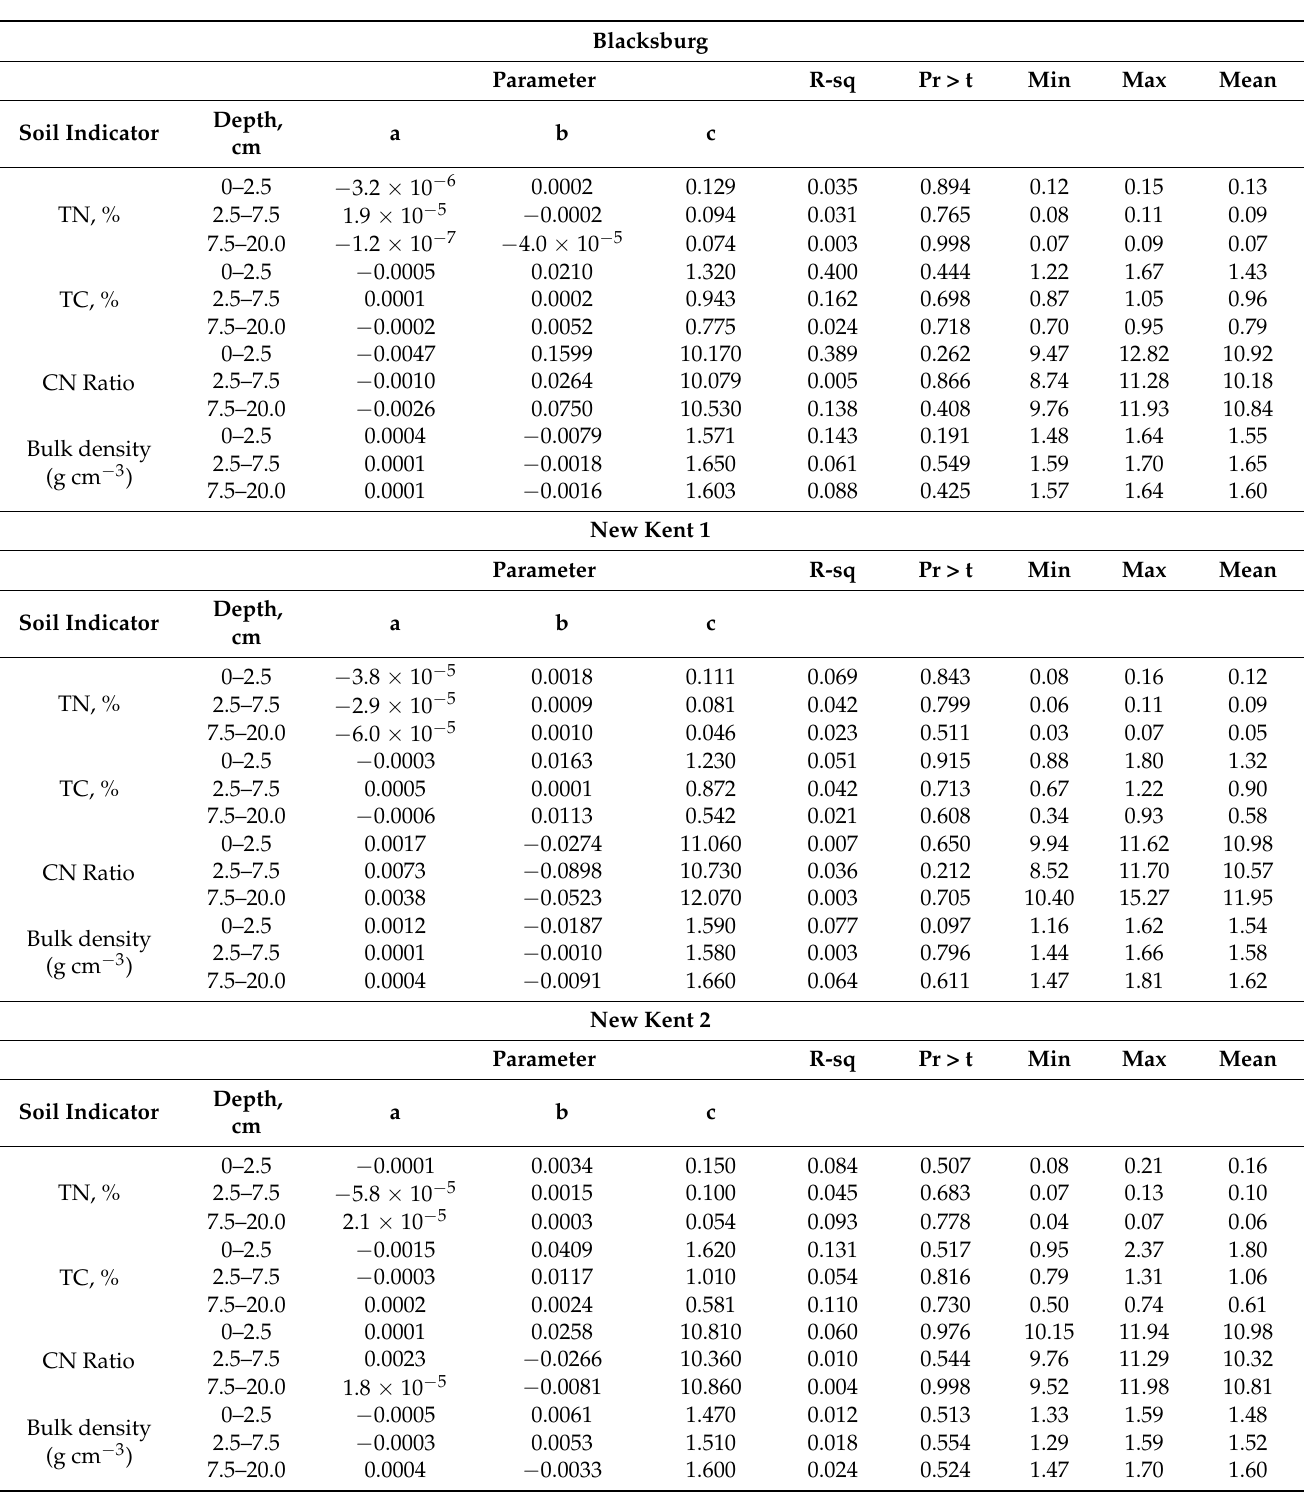
Table 4. Quadratic regression parameters, R square coefficient of determination, p -value, minimum, maximum and mean response values for total carbon (TC) and nitrogen (TN) (%), CN ratio and bulk density (g cm − 3 ) measured at the 0–2.5, 2.5–7.5 and 7.5–20 cm soil depths in 2017 in Blacksburg